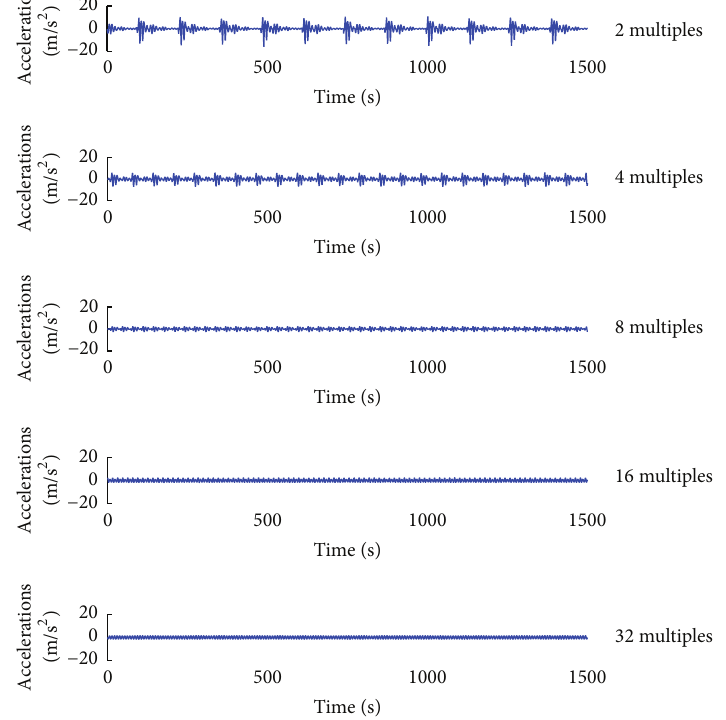
Figure 2: Vibration accelerations of the driving motor with different subdivision